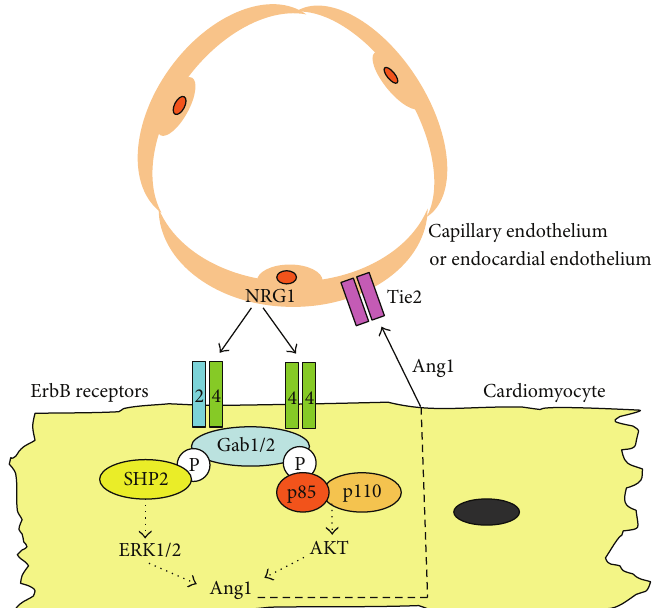
Figure 2: Schematic illustration of the roles of Gab docking proteins in the myocardium. Neuregulin-1 (NRG-1) shed from the capillary or endocardial endothelium in the heart activates the ErbB receptors expressed on cardiomyocytes, leading to the tyrosine phosphorylation of Gab1 and Gab2 and subsequent activation of ERK1/2 and AKT. NRG-1/ErbB-Gab1/Gab2 signaling in the myocardium is directly required for the postnatal maintenance of myocardial function. Furthermore, NRG-1/ErbB-Gab1/Gab2 signaling indirectly contributes to the postnatal stabilization of capillary or endocardial endothelium via the upregulation of angiopoietin-1 (Ang1). Ang1 derived from myocardium activates the Tie2 receptor, which is expressed on the cardiac endothelial